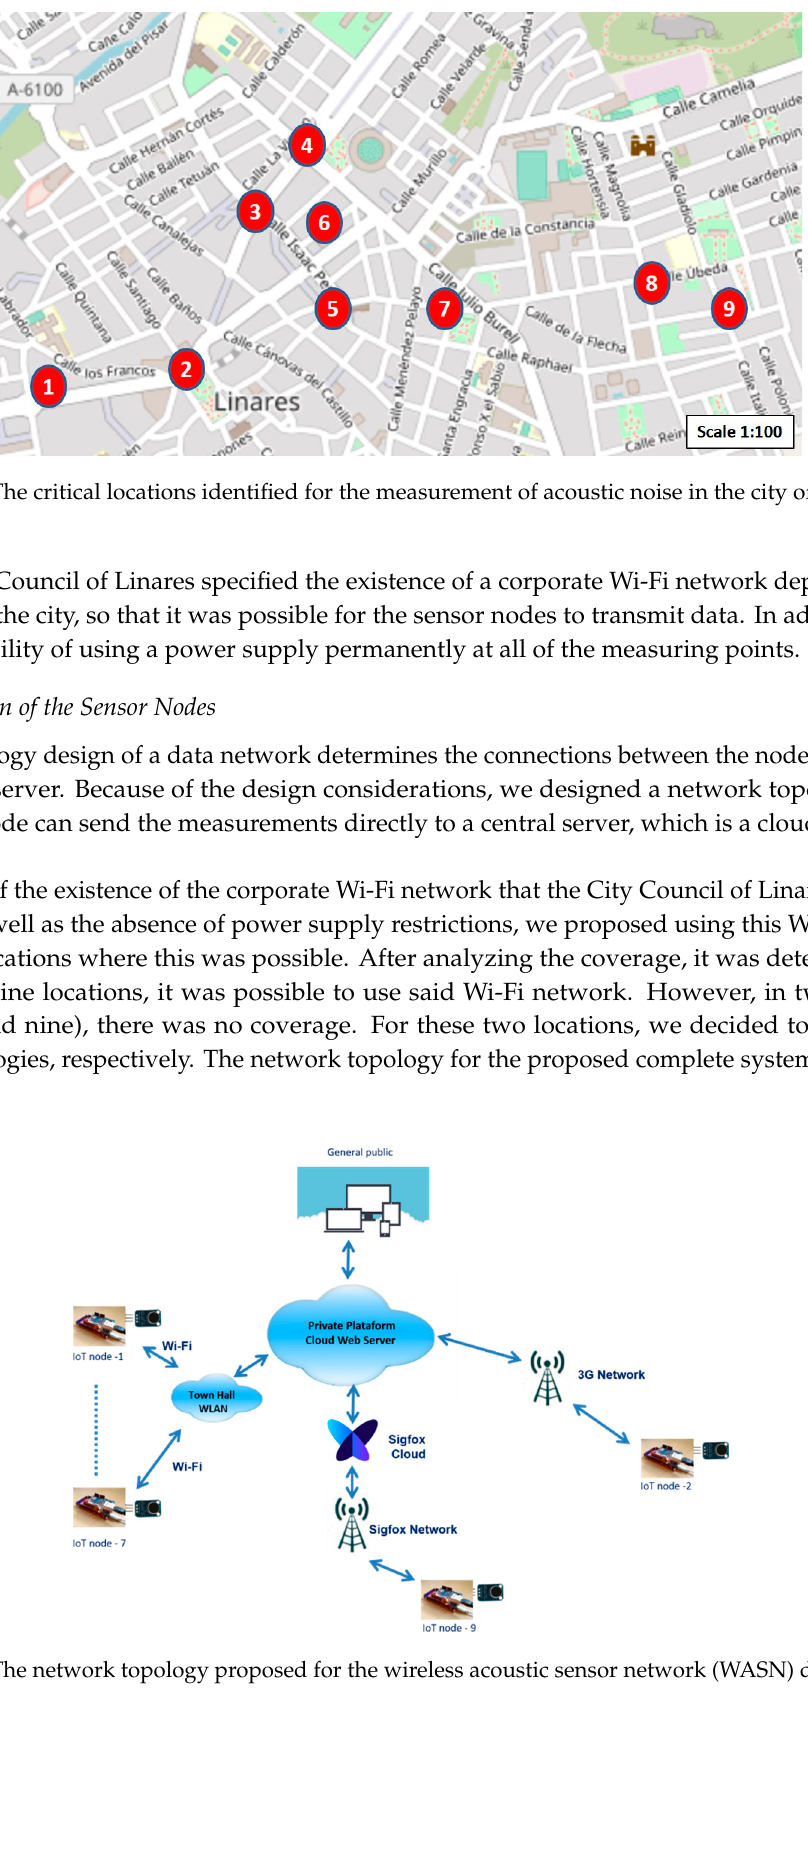
Figure 2. The network topology proposed for the wireless acoustic sensor network (WASN) deployed in the city.